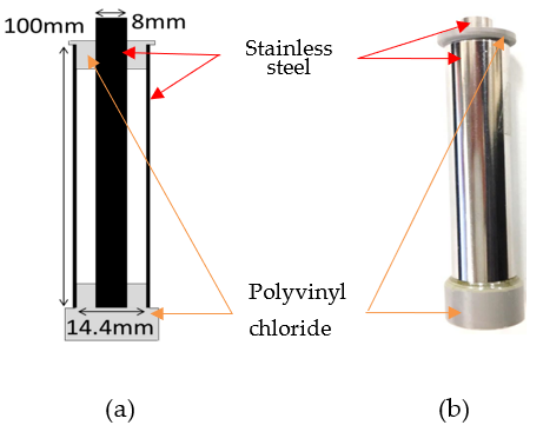
Figure 3. Cross-sectional diagram ( a ) and photograph ( b ) of the electrodes. The electrode had a coaxial cylindrical-type structure. Stainless steel was used as the conductor of the electrode, and vinyl chloride was used as the insulator. A pulse voltage was applied with the center conductor acting as the anode and the outer conductor as the cathode.